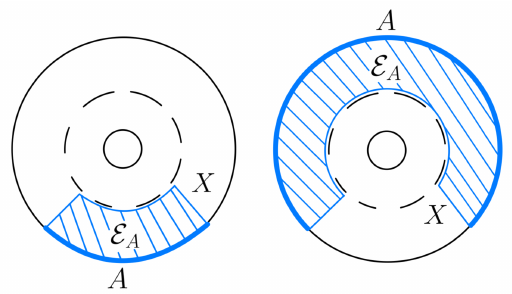
Figure 2 . The spatial slice of BTZ black hole. The outer circle is the τ = 0 boundary spatial slice. The inner circle is τ = ± β that we identify. The middle dashed circle is the (Euclidean) black hole 2 horizon. The thick blue lines are two different boundary replicated lines A . The surface E A is the extension of the replicated line inside the bulk. The blue line X is its boundary, and the would-be extremal RT